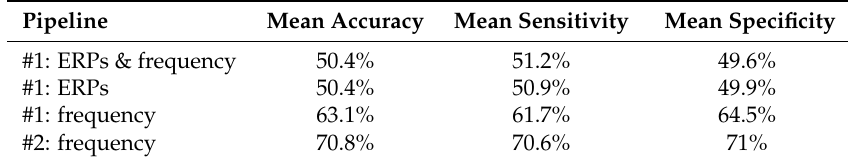
Table 1. Single trial classification results for the different pipelines.